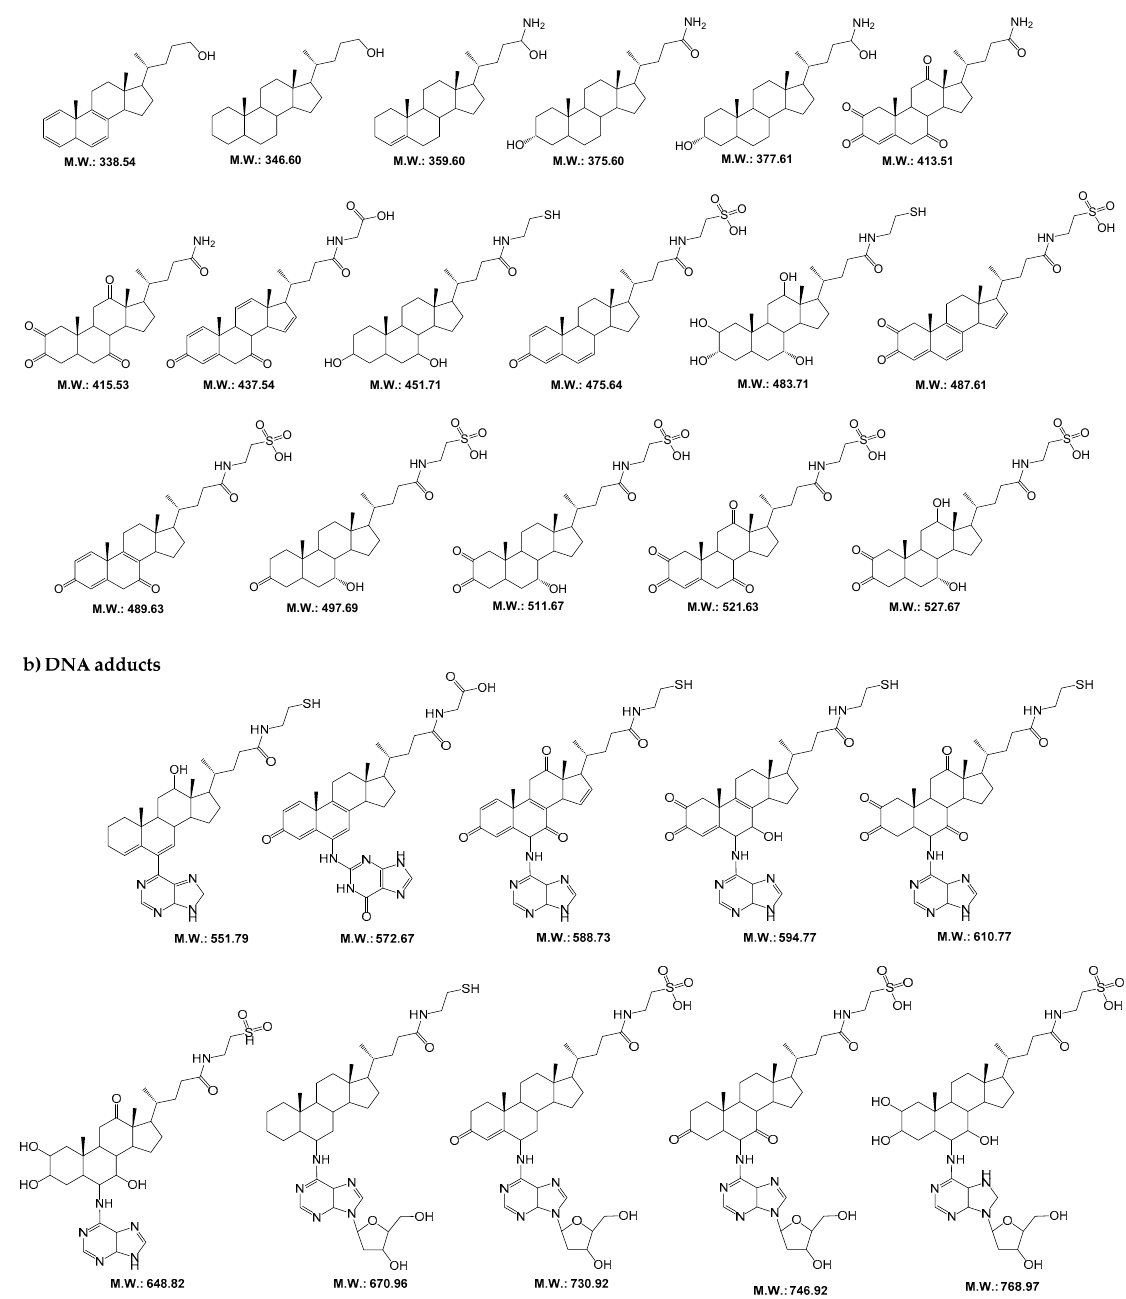
Figure 1. Postulated molecular structures for ( a ) metabolites precursors and ( b ) DNA adducts originated from the reaction of glycocholic acid and taurochenodeoxycholate sodium with calf thymus DNA in vitro in presence of CYP450 isoforms. (M.W., molecular weight).